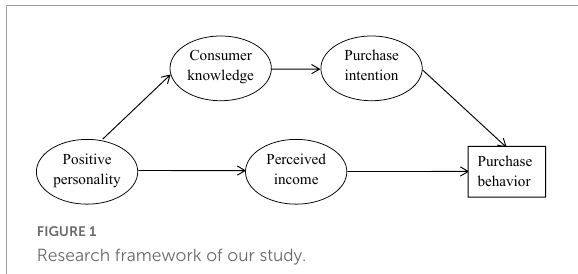
FIGURE1 Research framework of our